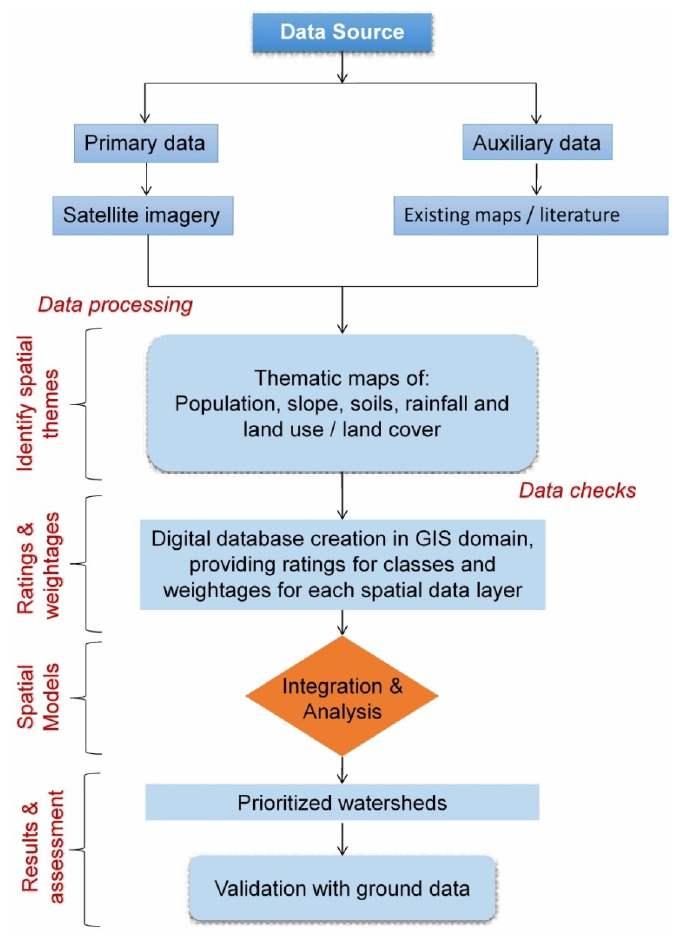
Figure 2. Overview of the methodology for watershed prioritization using integrated remote sensing and GIS techniques.